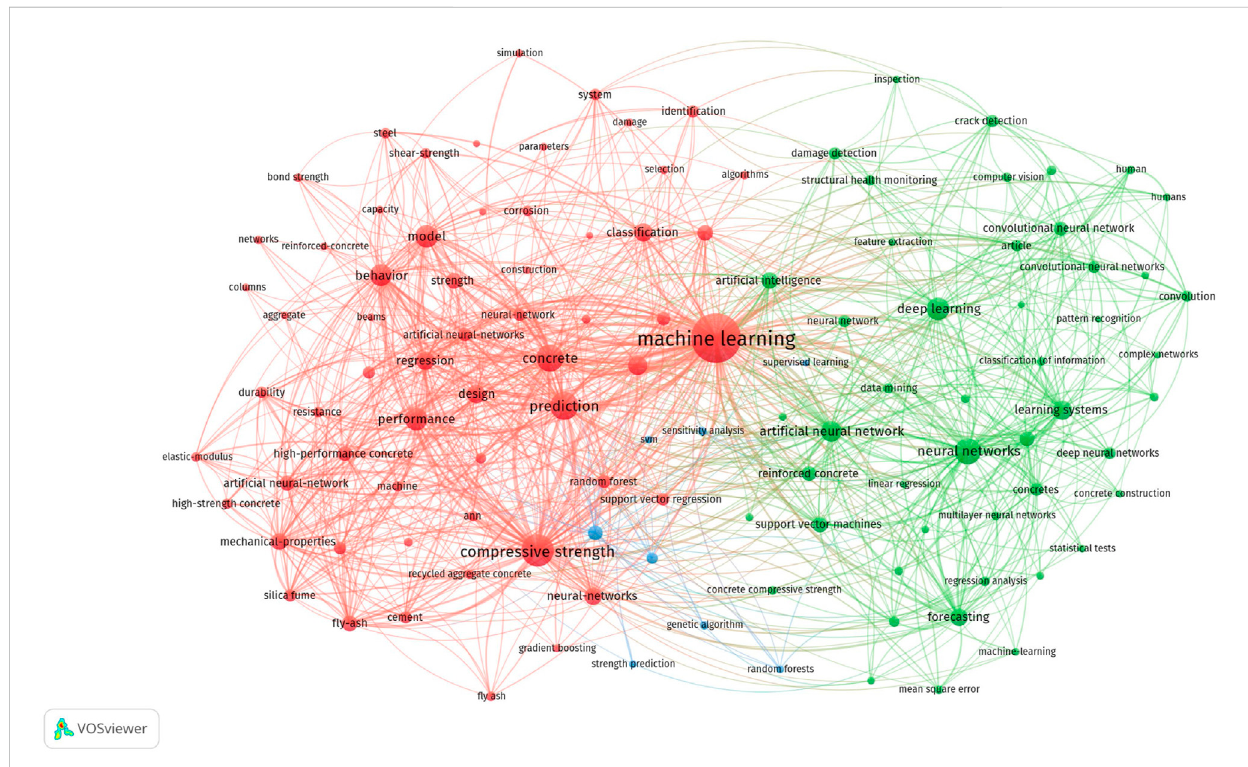
FIGURE 2 Network visualization of publications based on keywords.